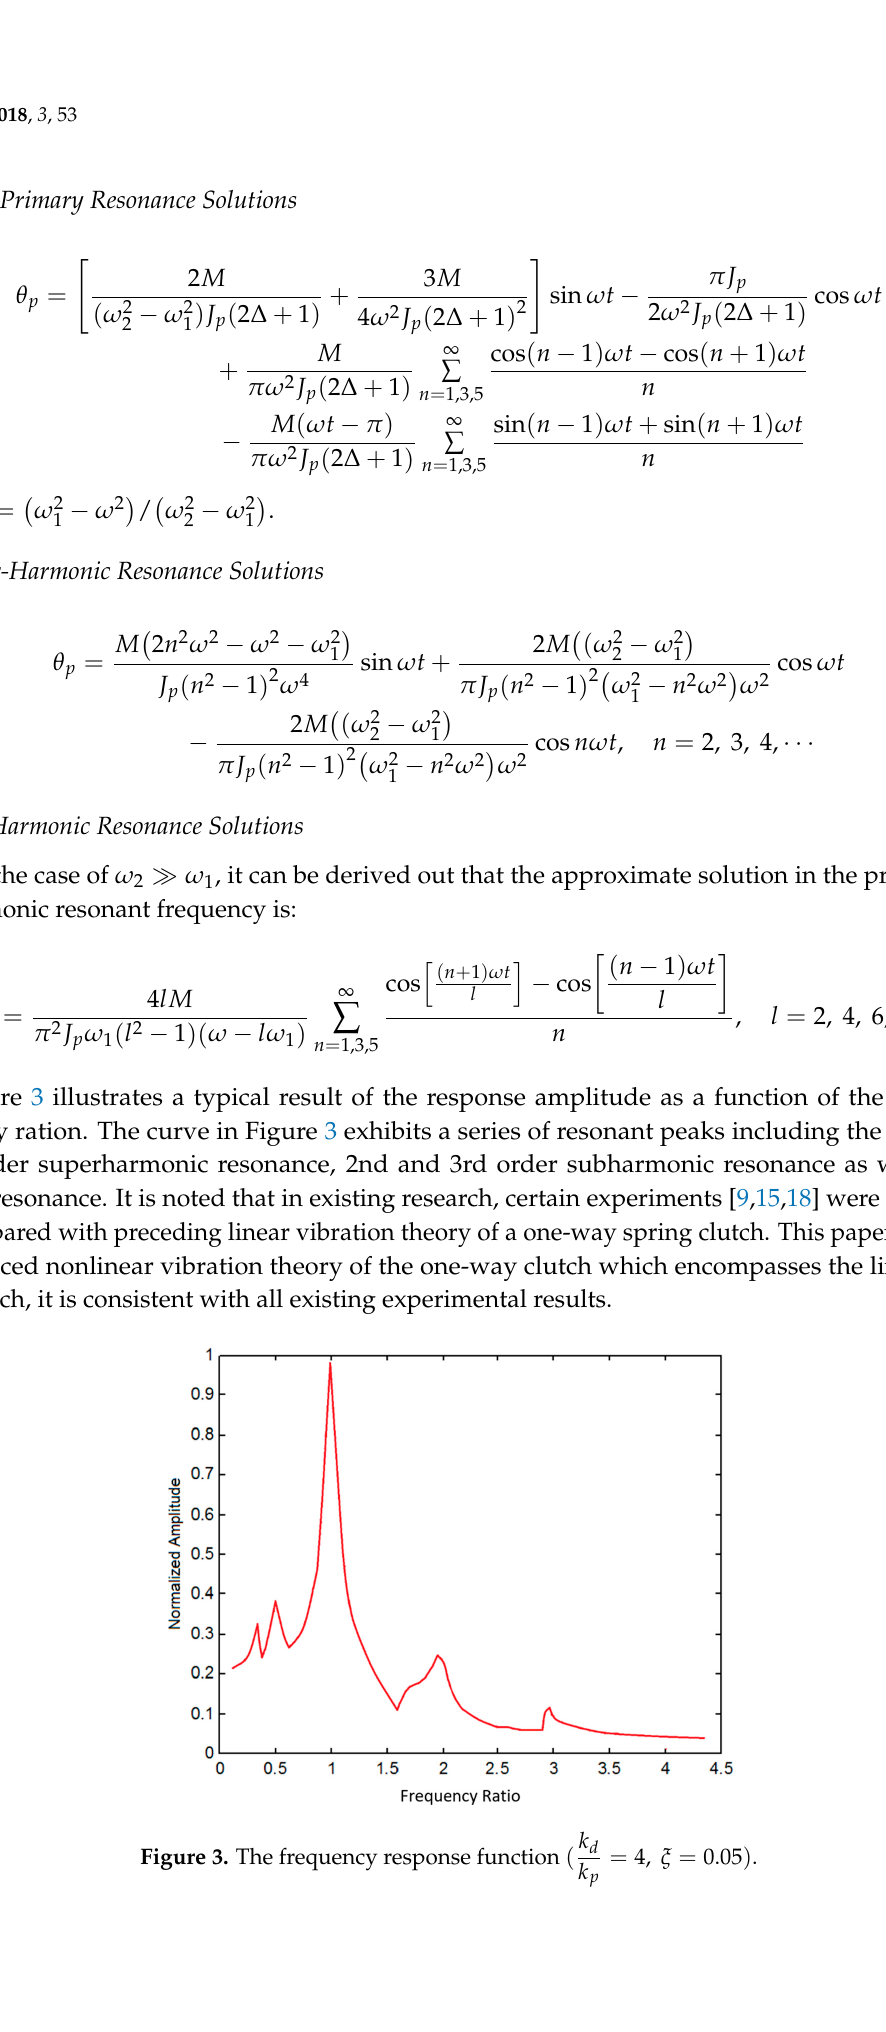
Figure 3. The frequency response function ( (cid:3038) (cid:3279)